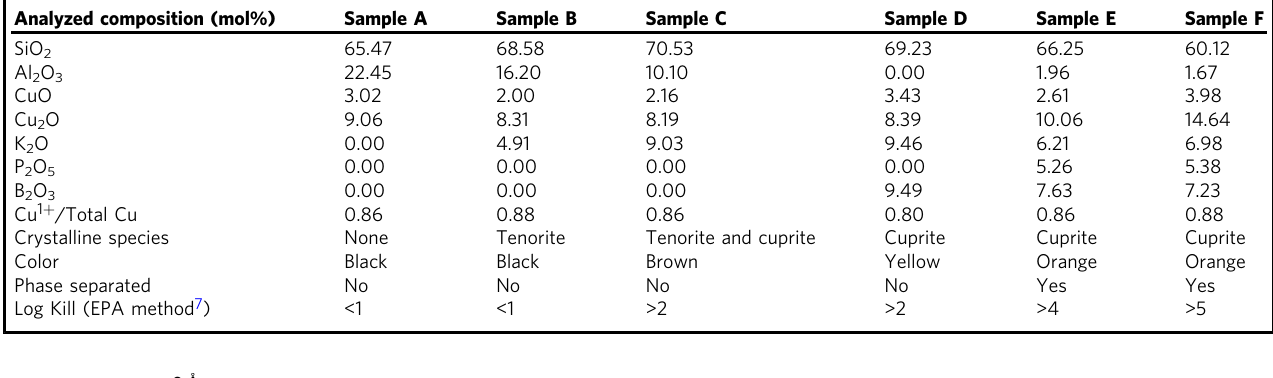
Table 1 Copper – glass and copper – glass ceramic compositions Analyzed composition (mol%)